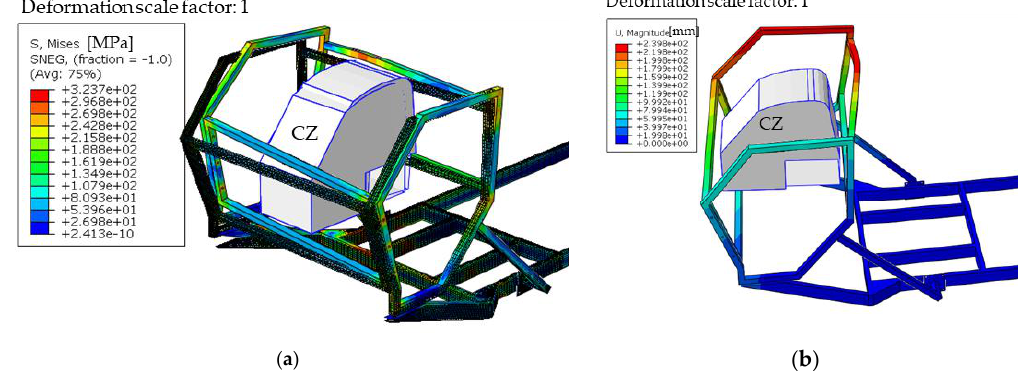
Figure 5. Longitudinal loading effects on ROPS and the clearance zone: ( a ) contour plot of Von Mises stress (expressed in MPa), 3D view; ( b ) displacement contour plot, 3D view without undeformed shape superimposition (expressed in mm).